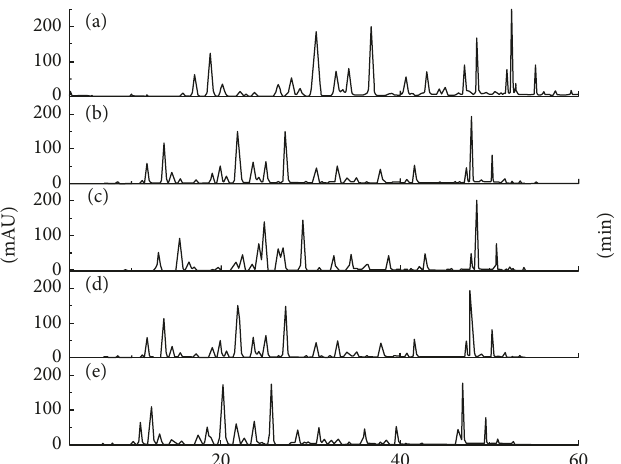
Figure 1: Optimization of LC fl ow rate and column temperature using the sample eluted with 50% ethanol from extracts of lotus plumule from XT: (a) 0.2mL/min; (b) 0.3mL/min; (c) 25 ° C; (d) 30 ° C; (e) 35 ° C. Table 1: Regression equation, regression coe ffi cients, linearity, LOD, and LOQ of four fl avonoid standards. Compounds Regression equation R 2 Linear range ( μ g/mL) LOD ( μ